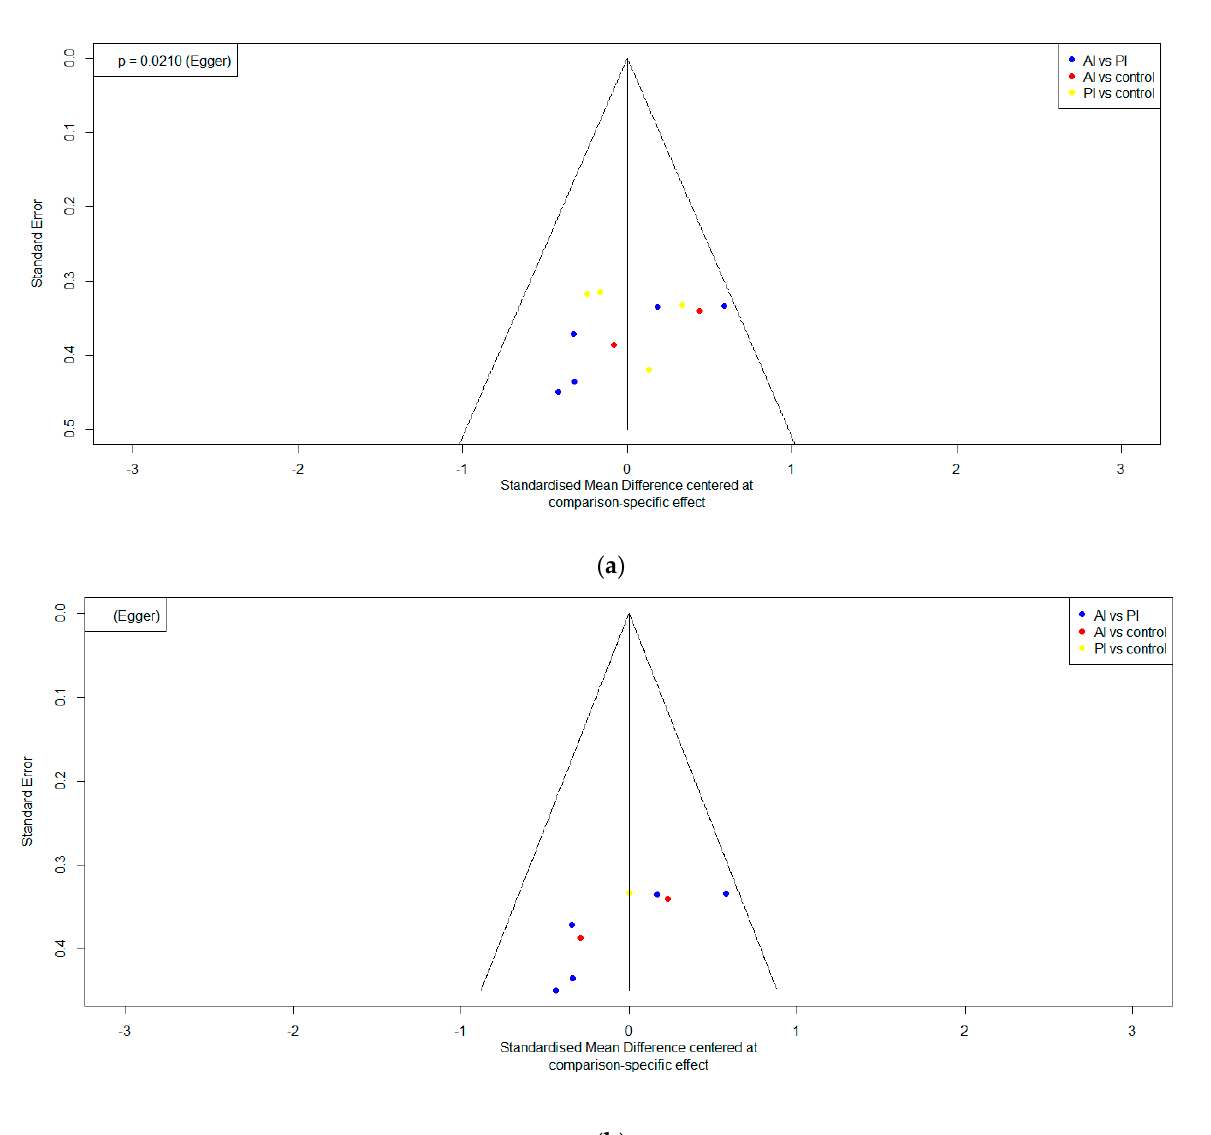
Figure 5. Funnel plot of publication bias of ( a ) pain and ( b ) navicular